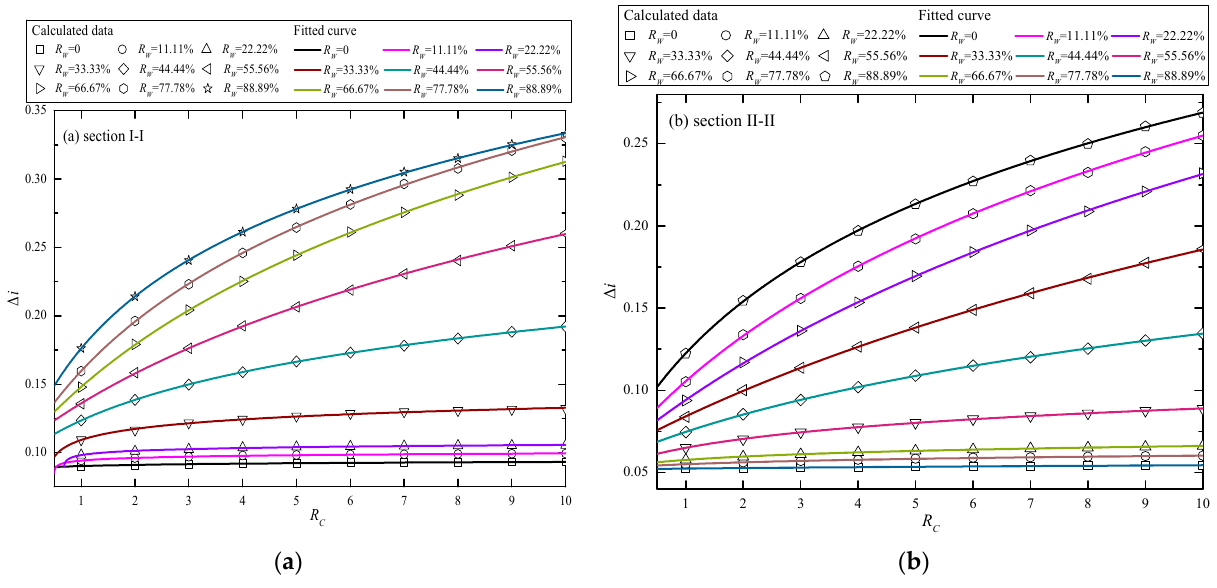
Figure 13. Relationship between Δ i and R C when R W changes from 0 to 88.89%: ( a ) section I-I; ( b ) section II-II. Figure 14 presents the relationship between Δ i and R C when R W is 77.78%, of which all the relationship can be fitted by logarithmic curve. Groundwater supply from outside to inside requires flow from the bottom of the diaphragm wall, which means vertical permeability is important for the seepage process. Because of the large value of R C and low vertical hydraulic conductivity, groundwater supply becomes difficult and Δ i increases. The acceleration of Δ i decreases, and due to the decrease of vertical hydraulic conductivity is limited.